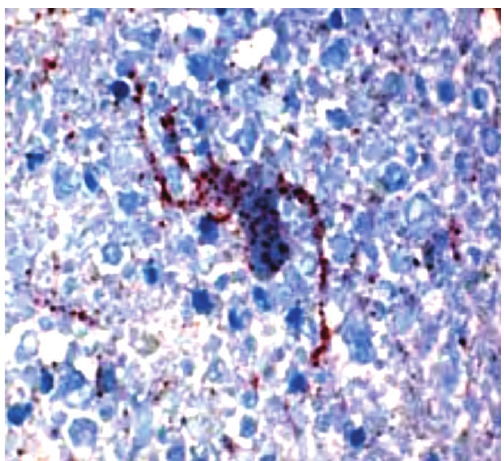
Figure 4: The Direct Rapid Immunohistochemical Test (dRIT) technique done on a human brain positive for rabies. Note the presence of brownish red particles in a neuron spreading along dendrites and